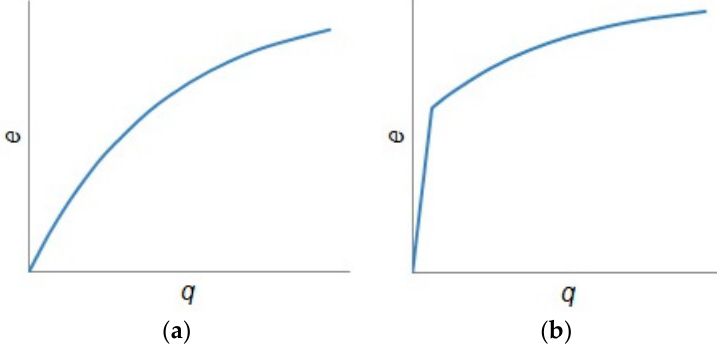
Figure 1. Types of plots of extraction yield against the solvent-to-feed ratio. ( a ) Smooth curve; ( b ) initial straight line and a break to smooth curve.